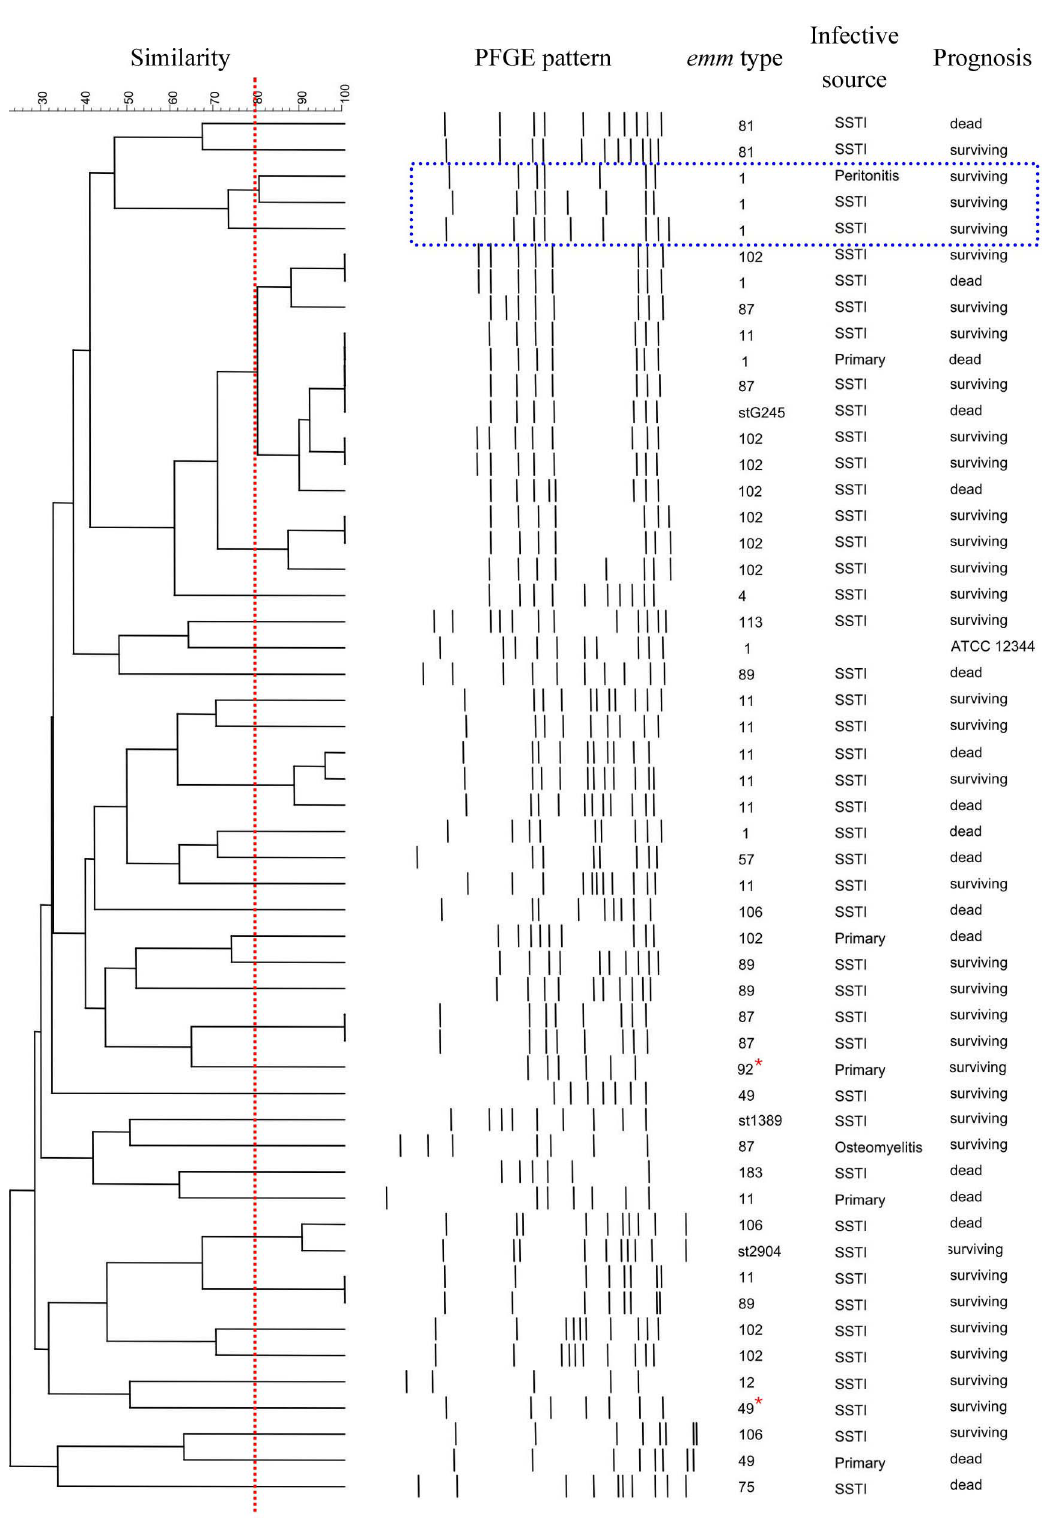
Figure 3. Dendrogram of pulsed-field gel electrophoresis (PFGE) among isolates of Streptococcuspyogenes . Thirty-five PFGE clusters with $ 80% similarity were identified among the 52 isolates of S. pyogenes . The majority of the isolates were grouped according to their emm type. Most emm 102 belonged to the largest cluster. The nonfatal emm 1 isolates were grouped together (in the rectangle outlined by a broken line) and distributed apart from the fatal isolates. Streptococcus pyogenes ATCC 12344 was used as a control strain. SSTI, skin and soft-tissue infection; *, isolates digested using Cfr9I.